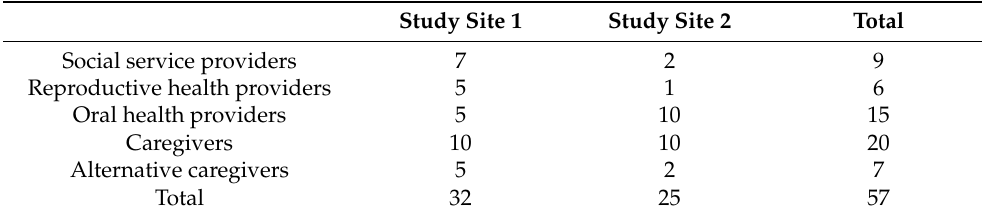
Table 1. Provider and caregiver